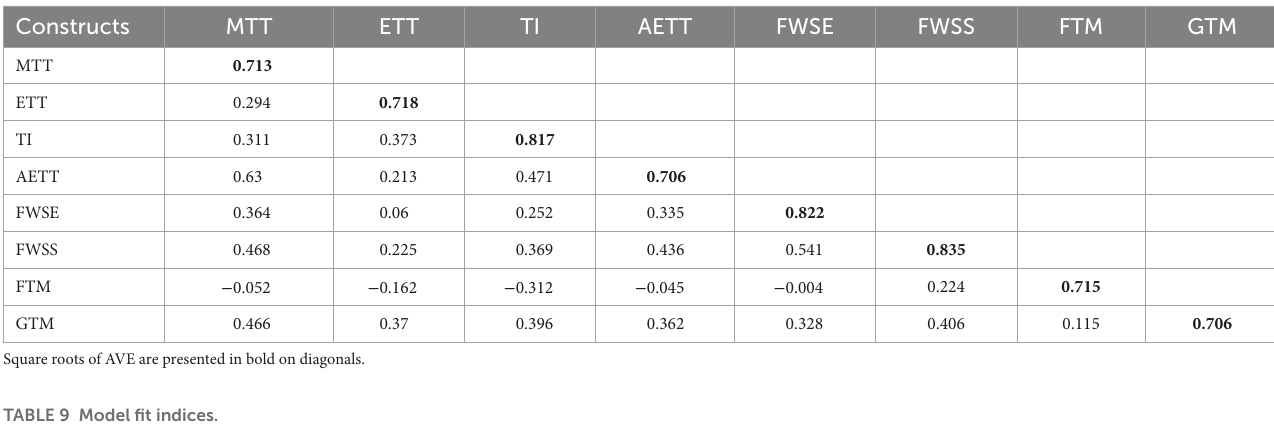
TABLE 8 Discriminant validity